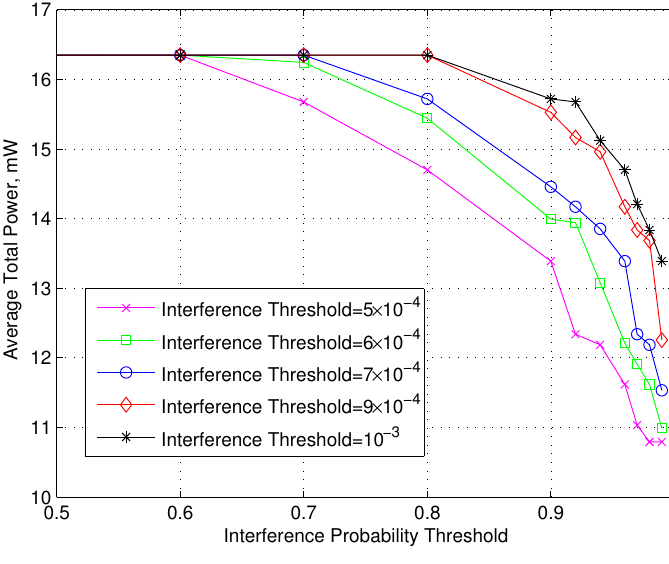
Figure 9. Total power vs. interference probability threshold for different interference